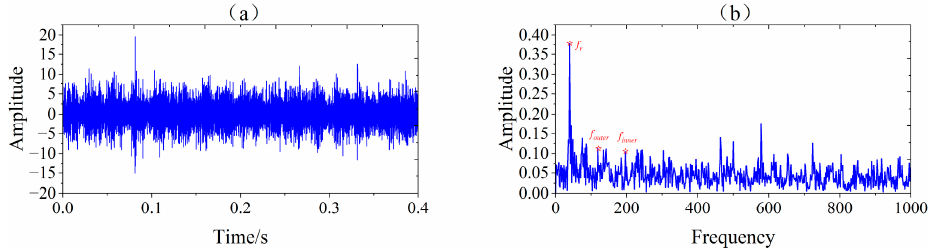
Figure 27. ( a ) The filtered signal from MED by processing the selected PF in the compound fault signal, and ( b ) the envelope spectrum of filtered signal.